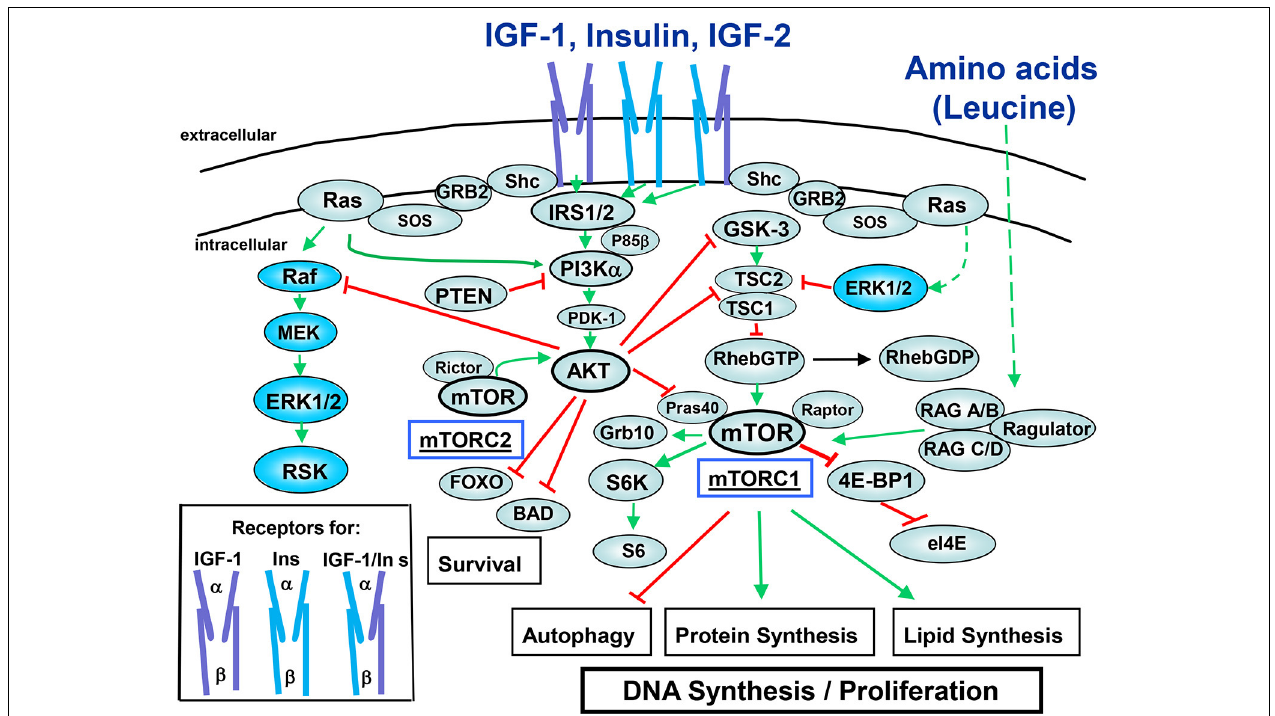
FIGURE 1 | Insulin/IGF-1 signaling pathways. The receptors for the peptides of the insulin family peptides consist of ligand-binding α chain and tyrosine kinase-containing β chain (cartoons in the box). Insulin binds to the insulin receptors (InsR) with high affinity while it binds to IGF-1R at higher concentrations. Insulin also binds to hybrid receptors (IGF-1R/InsR). IGF-1 binds to the IGF-1R and to hybrid receptors with high affinity. IGF-2 binds to the InsR-A, IGF-1R, and IGF-1R/InsR-A hybrid receptor. For the sake clarity, negative feedback loops mediated by